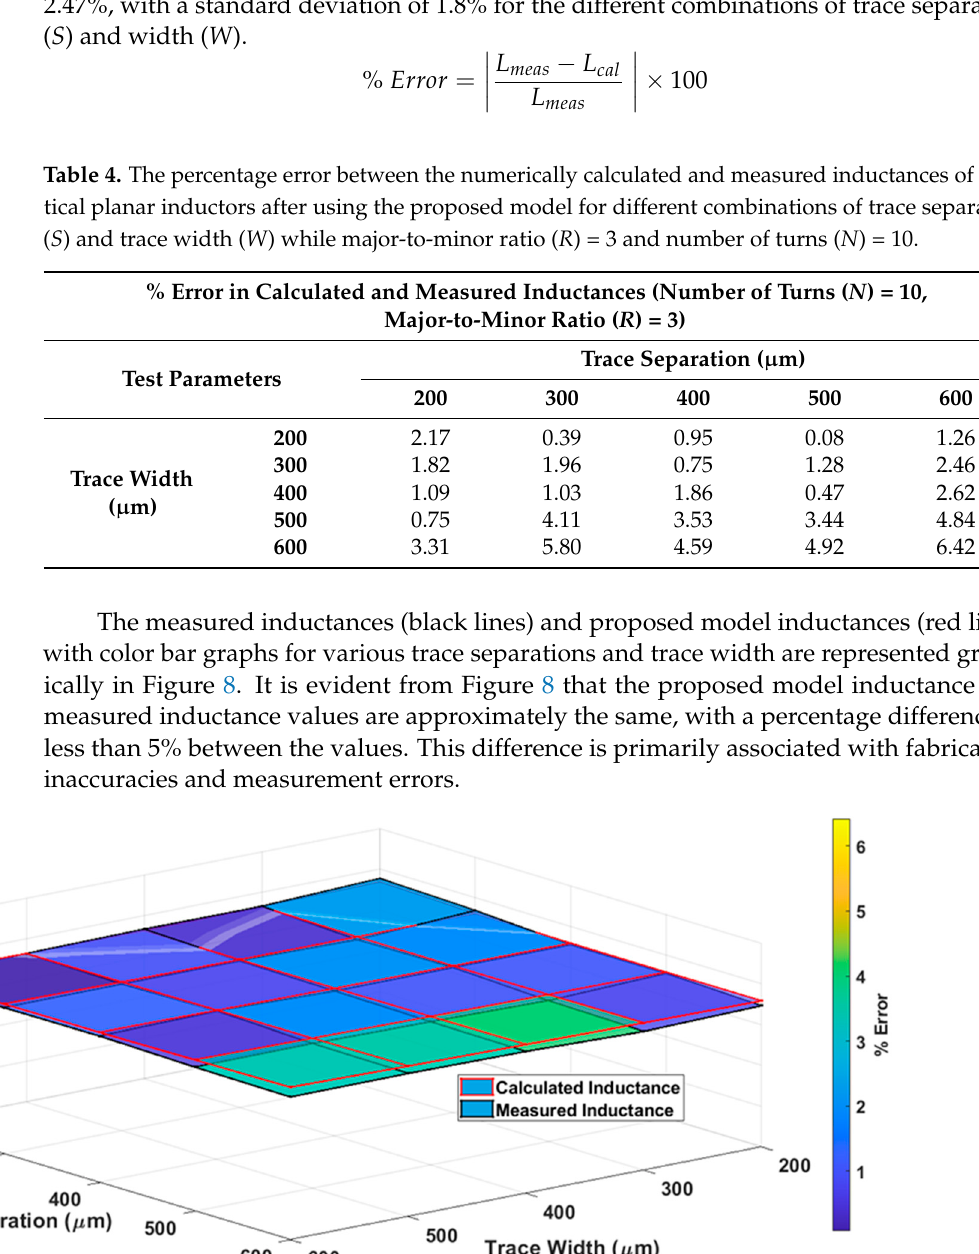
ues of the elliptical planar inductor is computed using Equation (19) and given in Table 4. A maximum error value of 6.42% was found when the trace separation and trace width were 600 μ m, while the minimum error was found to be 0.08% when the trace separation ( S ) and trace width ( W ) were 500 μ m and 200 μ m, respectively. However, the average error was 2.47%, with a standard deviation of 1.8% for the different combinations of trace separation ( S ) and width ( W ).